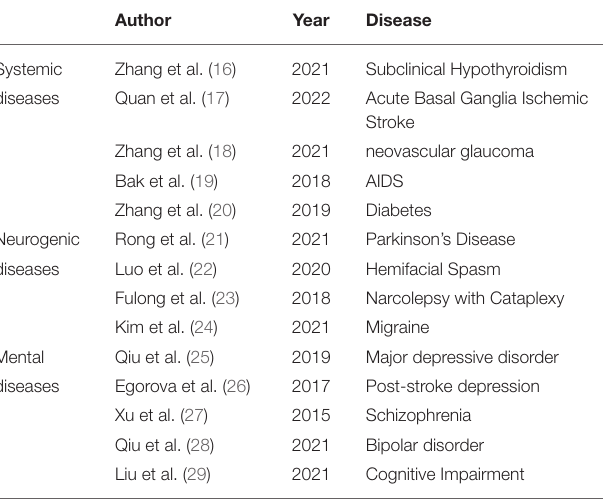
TABLE 3 | fALFF method applied in systemic, neurogenic and mental